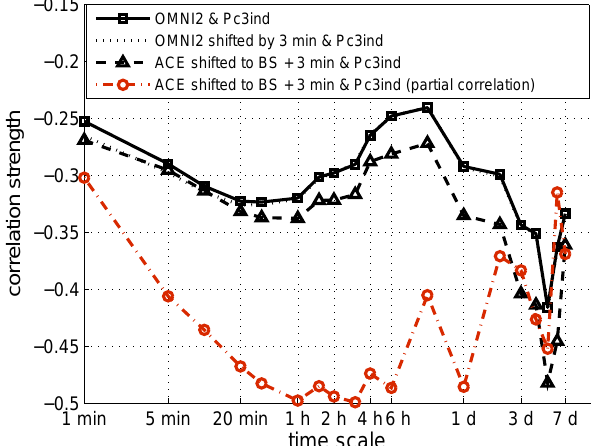
(colour scale) over x